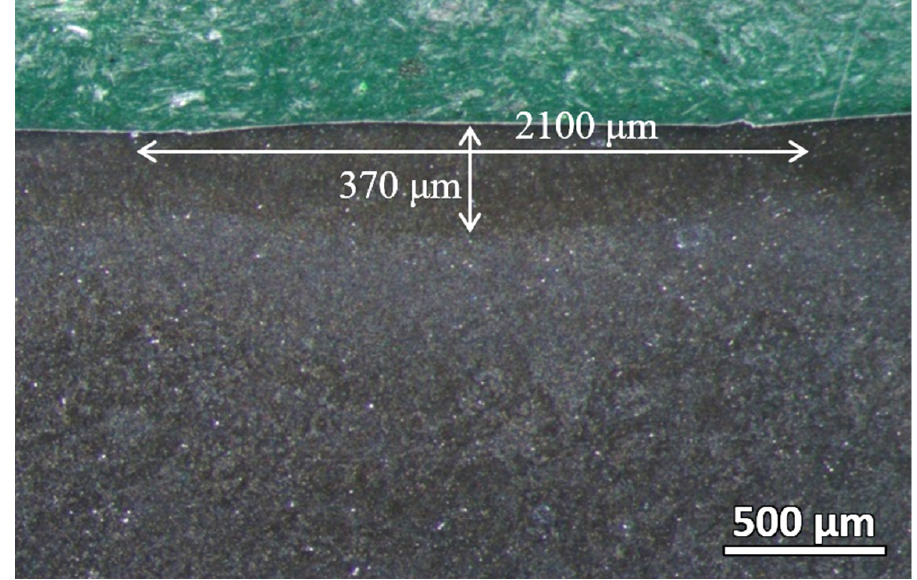
Figure 4. Melt pool dimension of the laser-hardened sample viewed by stereo microscope.